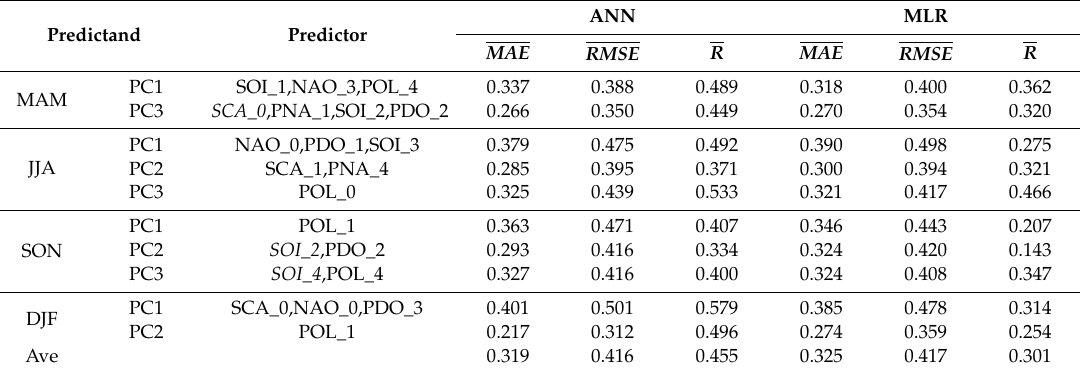
Table 3. Average mean absolute error (MAE), root mean square error (RMSE), and correlation between observations and simulation results (R) for three-fold cross-validation for ANN and multiple linear regression (MLR)